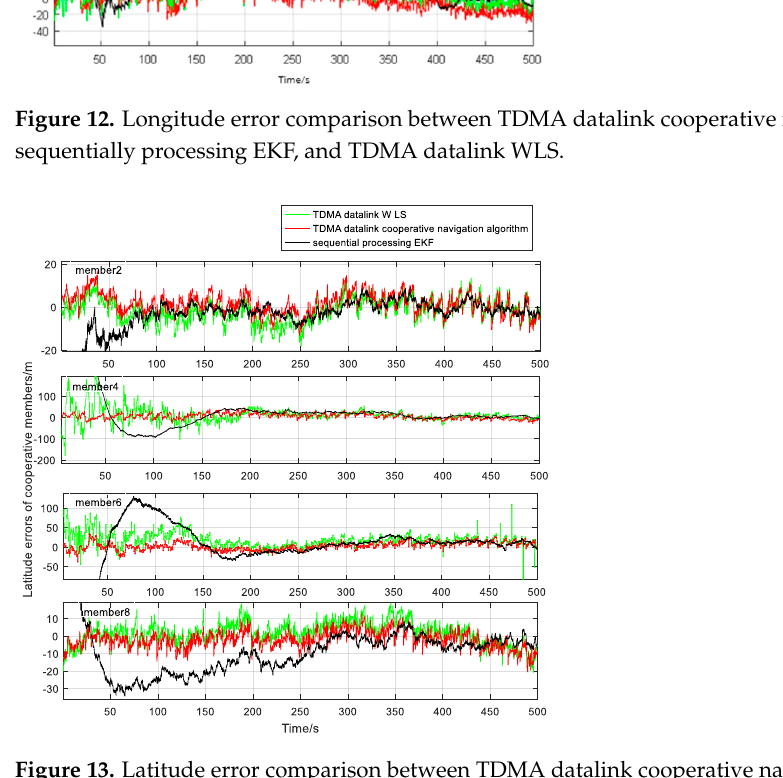
Figure 13. Latitude error comparison between TDMA datalink cooperative navigation, sequentially processing EKF, and TDMA datalink WLS.